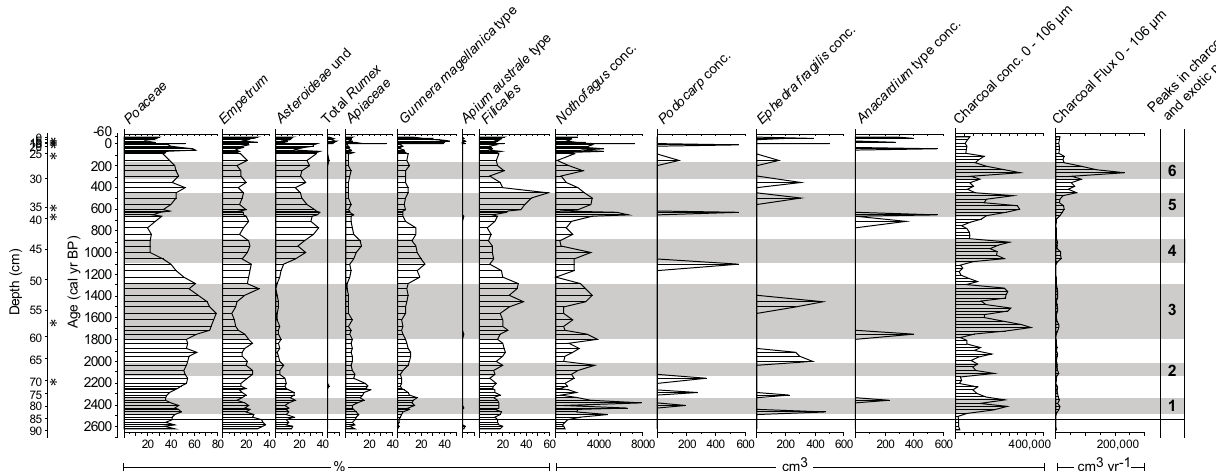
Figure 2. Pollen diagram from Canopus Hill, Port Stanley Airport, plotted against depth and calendar age. The location of 137 Cs and 14 C ages are marked by asterisk.